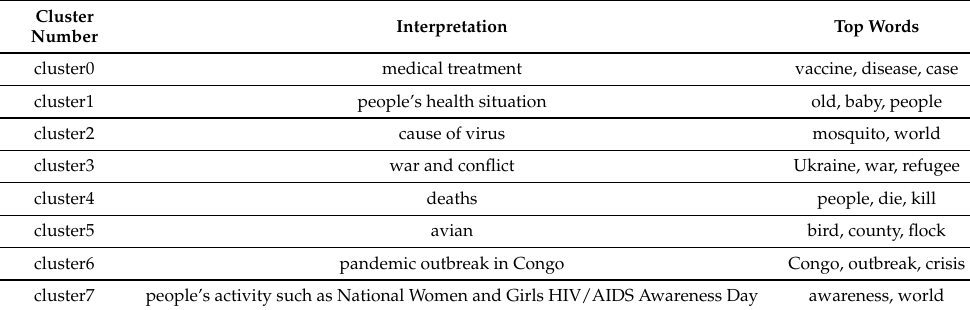
Table 1. Interpretation of clustering on